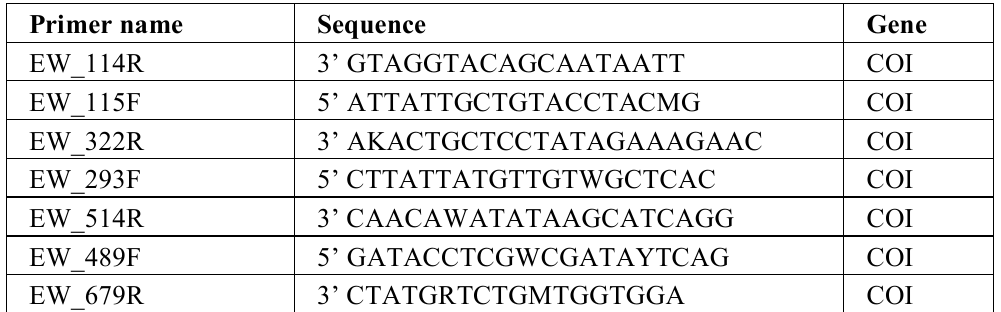
Table S2. Table of primers designed for this study to amplify the COI fragment in Anisolabis kaspar , incorporating the IUPAC